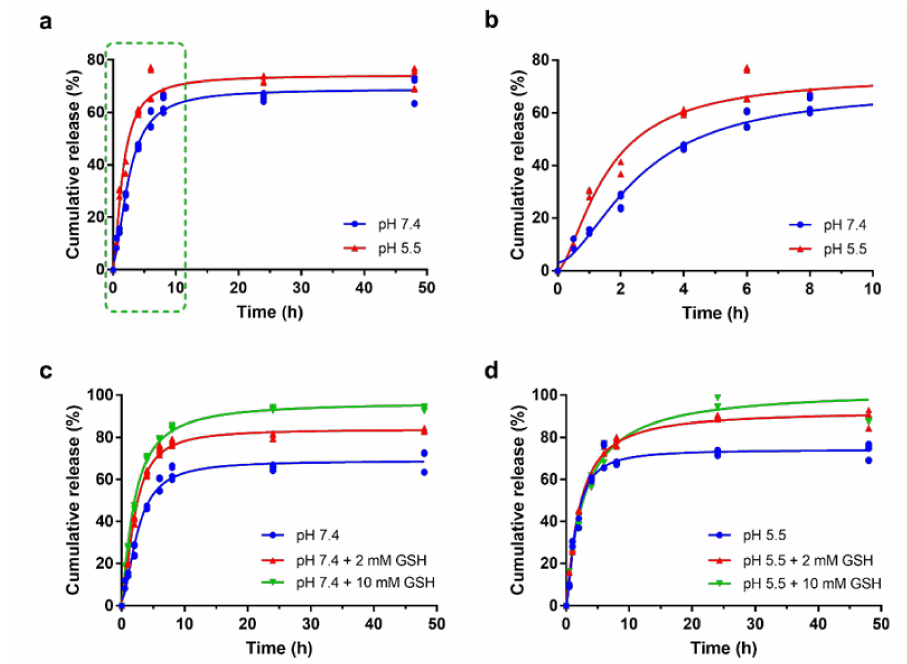
Figure 3. ( a ) Release profiles of Pt from Pt-Fe NCPs at 37 ◦ C at pH 7.4 and 5.5 in PBS using dialysis method; ( b ) Inset of release showing the first 8 h of the whole release profiles (corresponding to green dashed line square shown in ( a )). Each value represents the mean ± standard error (SE) of three independent experiments; Cumulative release of Pt from Pt-Fe NCPs in the absence or in the presence of GSH at ( c ) pH 7.4 and ( d ) pH 5.5. Each value represents the mean ± SE